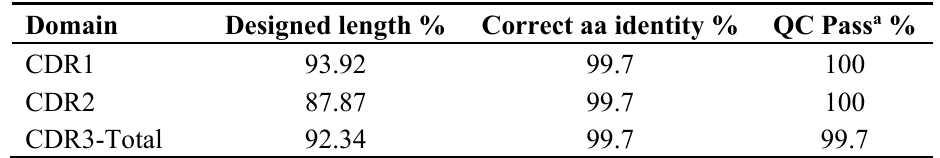
Table 2. Quality assessment of V HH libraries. NGS sequence data was assessed to determine the percentage of CDR regions of the designed length.